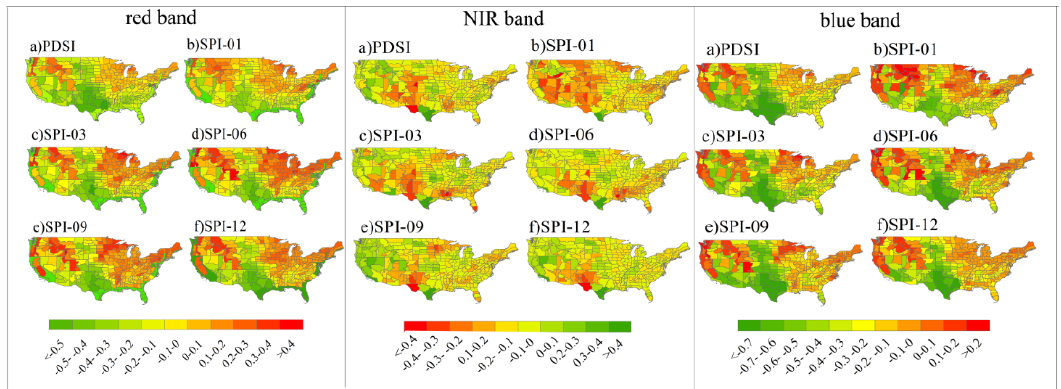
Figure 11. Spatial distribution of climate divisions with correlations (r-value) between red band, NIR band and blue band with in situ drought indices for the entire growing season (April to October) 2002–2011. The green color stands for the negative correlation and the red color stands for the posititive correlation.